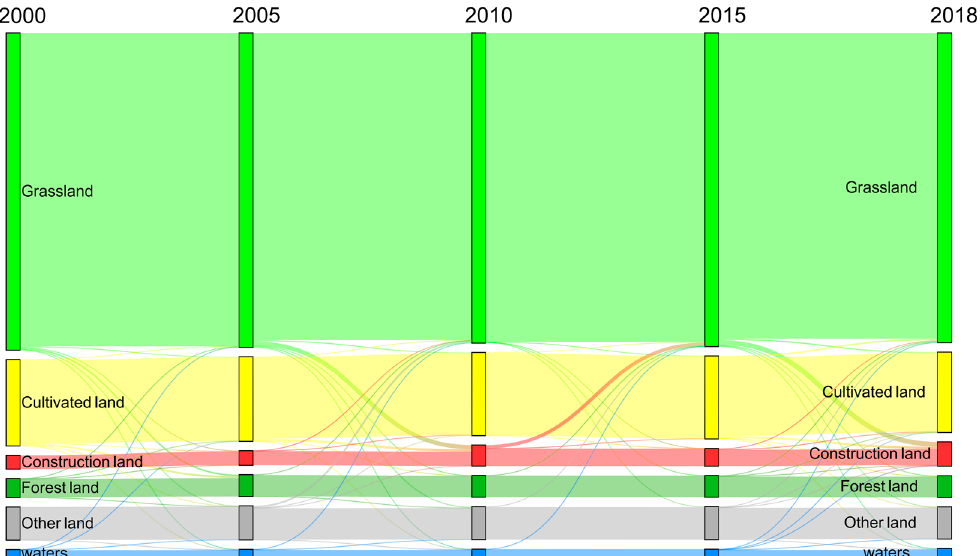
Figure 3. Spatial pattern of land use in Baotou from 2000 to 2018 (note: DMUB, BO, GY, KDL, JY, QS, SG, DH, and TRB refer to Darhan Muminggan United Banner, Bayan Obo, Guyang, Kundulun, Jiuyuan, Qingshan, Shiguai, Donghe, and Tumote Right Banner, respectively).